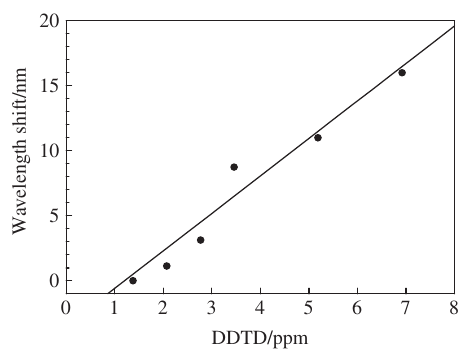
Figure 8 Fluorescence spectral shift of NR as a function of DDTD concentration ( Hassoon and Schechter 1998 ).